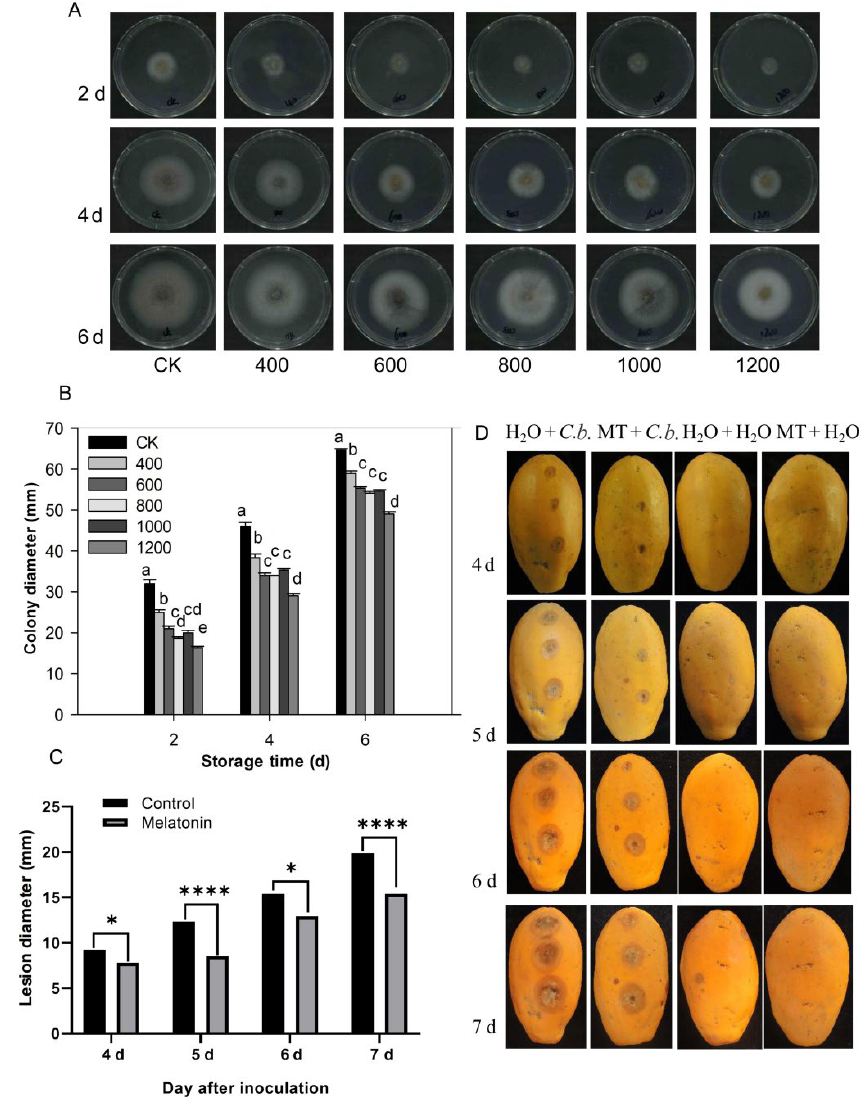
Figure 6. Effect of melatonin application on the development of C. brevisporum in vitro and in vivo. ( A ) Colony morphology of C. brevisporum on PDA medium with different concentrations of melato- nin. ( B ) The effect of melatonin treatment on colony diameter ( C ) and lesion diameter of anthrac- nose. ( D ) Disease symptoms on papaya fruit after inoculation for 4, 5, 6 and 7 days. Each data point denotes the mean ± SE (n = 3). Different letters show substantial differences at the 5% level. * and **** indicated a significant difference at 0.05 and 0.001 levels, respectively. CK: control group, “400”,